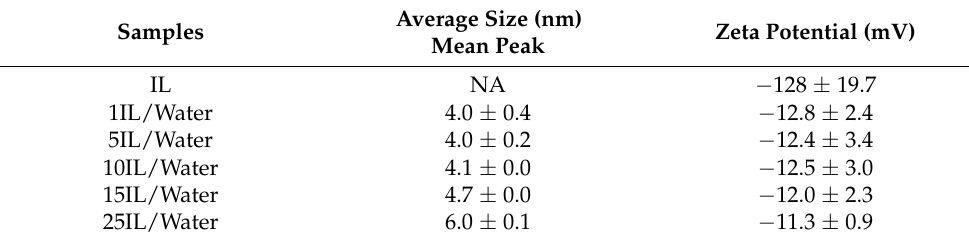
Table 3. Zeta Potential and Size dimension with the standard deviations for the single IL and its IL/Water